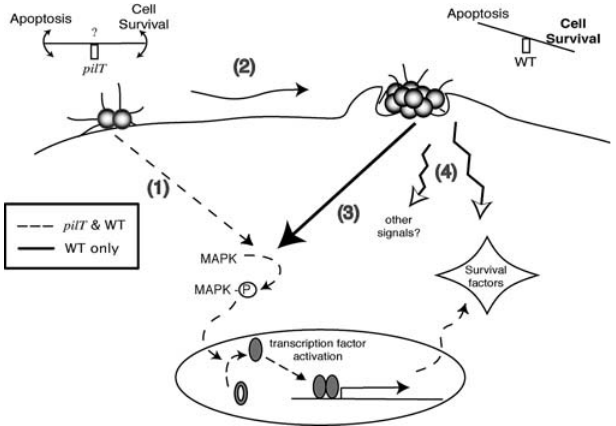
Figure 6. Model of the Role of Pilus Retraction in Promoting a Cytoprotective Environment during Gonococcal Infection of an Epithelial